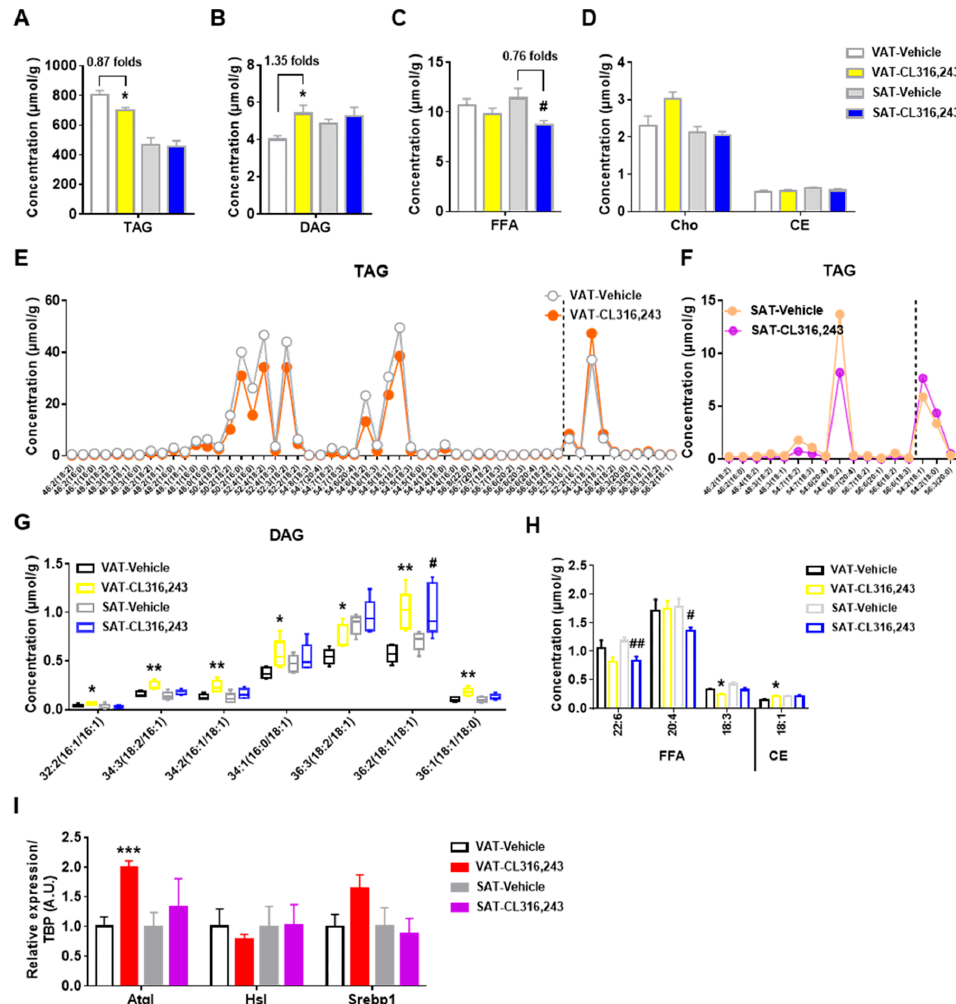
Figure 4. Exposure to CL316,243 differentially affected the abundance of glycerides in VAT and SAT. The total abundance of ( A ) triacylglycerol (TAG), ( B ) diacylglycerol (DAG), ( C ) free fatty acids (FFA), ( D ) cholesterol (Cho), and cholesteryl ester (CE) were detected. The concentration of significantly changed TAG molecular species in ( E ) VAT and ( F ) SAT of mice after CL316,243 injection. The dotted lines separate the raised and lowered species; ( G ) The amount of significantly altered DAG subclasses in VAT and SAT from vehicle and CL316,243-treated mice; ( H ) The abundance of dramatically changed molecular species of FFA and CE in VAT and SAT of mice after CL316,243 treatment. Data are presented as mean ± SEM, n = 5. * P < 0.05; ** P < 0.01 compared with VAT Vehicle group. # P < 0.05; ## P < 0.01 compared with SAT Vehicle group. ( I ) qPCR analysis of adipose triglyceride lipase (Atgl), hormone-sensitive lipase (Hsl), and sterol regulatory element-binding protein 1 (Srebp1) gene expression in VAT and SAT of mice injected with CL316,243. qPCR data are normalized to TBP and presented as mean ± SEM, n = 5. *** P < 0.001 compared with VAT Vehicle